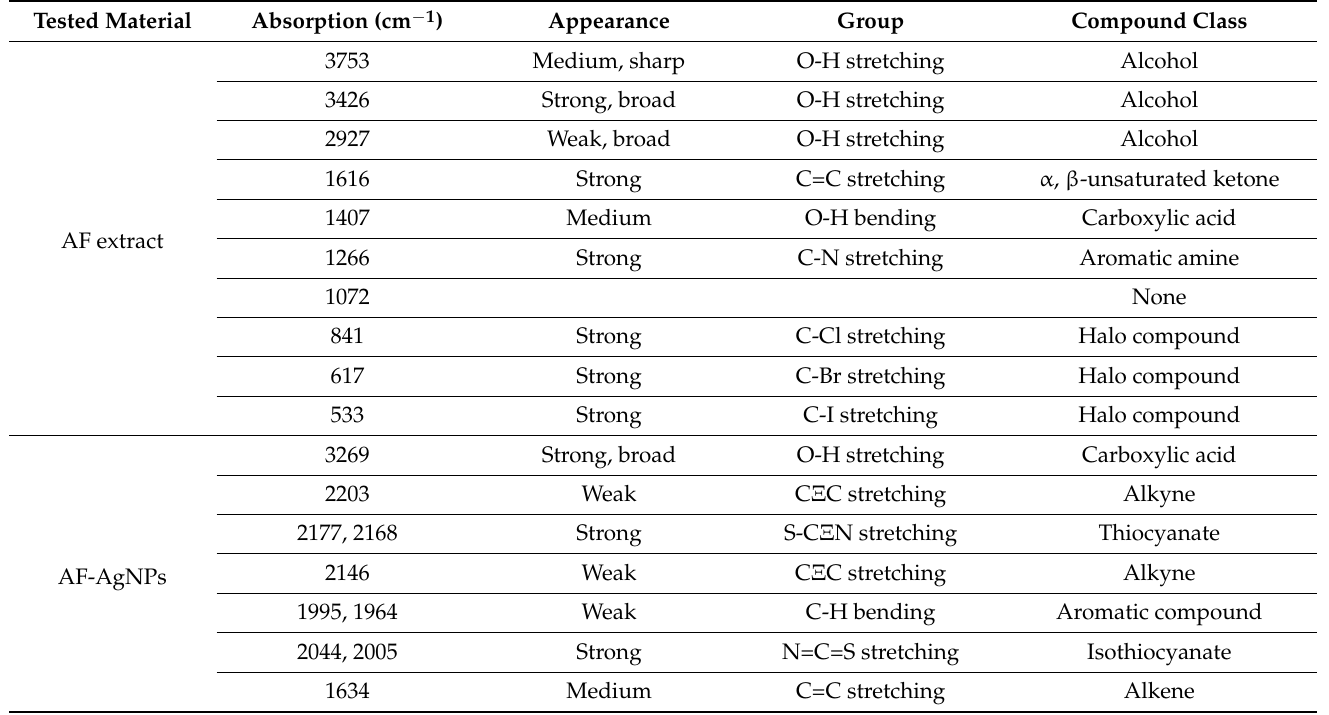
Table 2. The functional group analysis by